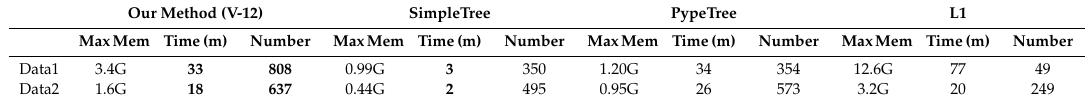
Table 2. Comparison on maximum memory, run time, and number of skeletons of di ff erent methods.